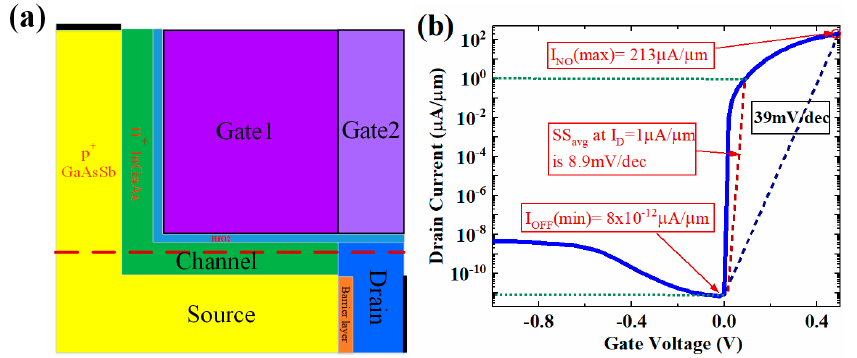
Figure 1. ( a ) Structure of the proposed InGaAs/GaAsSb HJ-LTFET; ( b ) the transfer characteristic of HJ-LTFET.